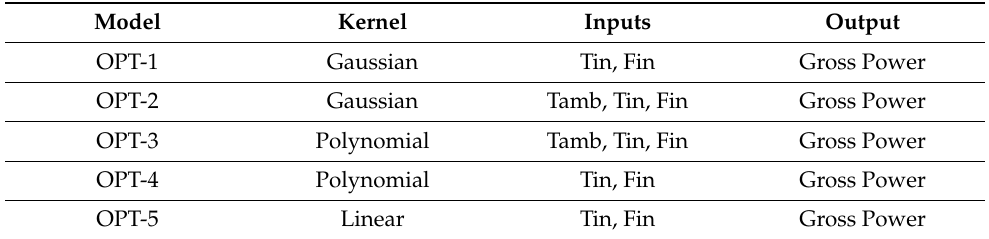
Table 2. Validation with Plant A data. (T amb is the ambient temperature, Tin is the PB inlet tempera- ture and Fin is the PB inlet flow).